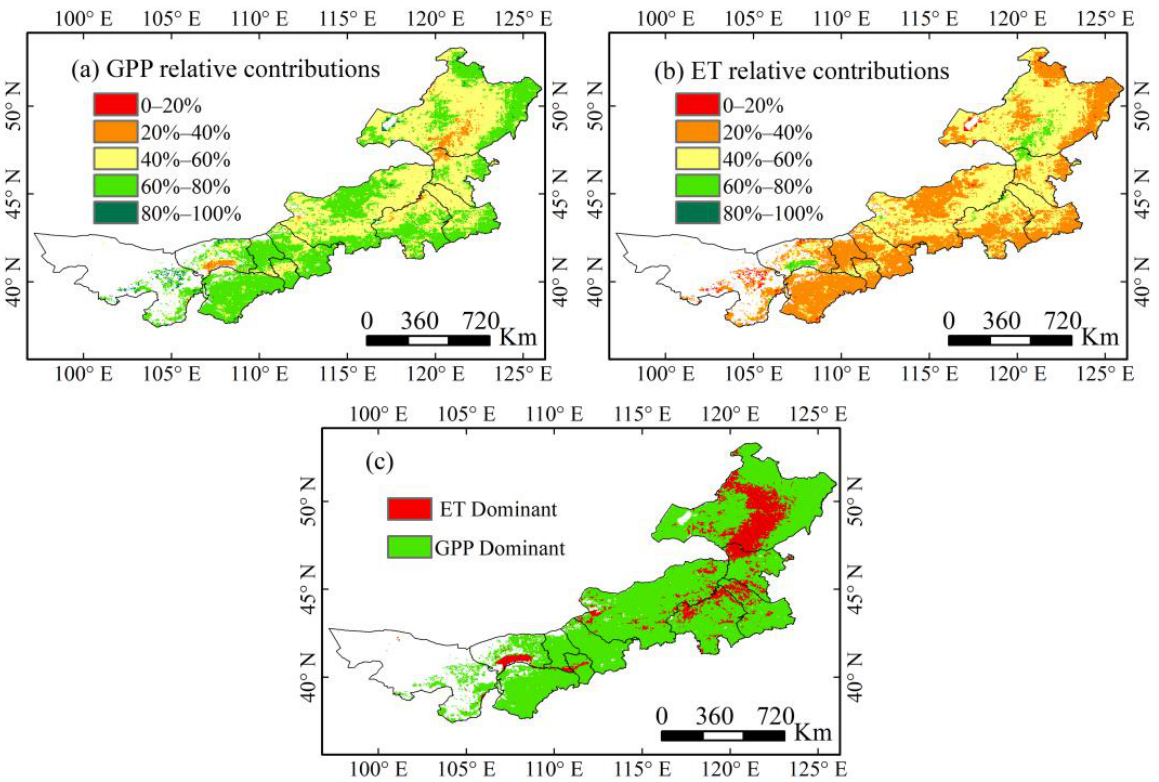
Figure 8. Spatial pattern of relative contributions of ( a ) GPP and ( b ) ET to WUE in Inner Mongolia from 2001 to 2020; ( c ) Spatial distributions of dominant controlling factors (i.e., GPP or ET).